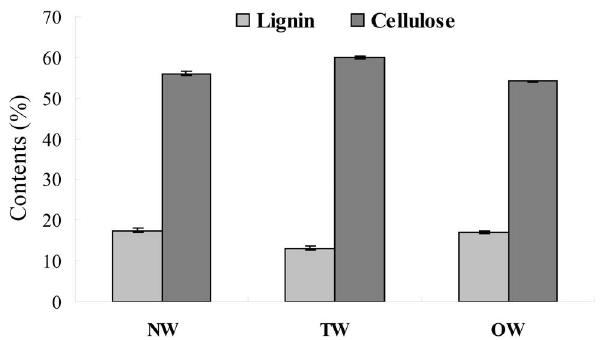
and lignin content are expressed as a percentage of cell wall residue